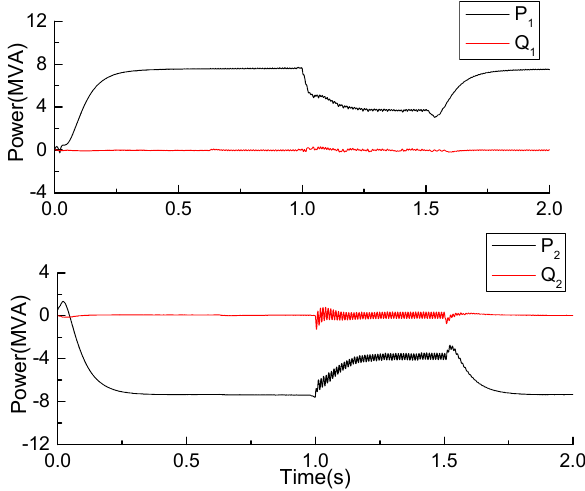
Figure 13. Secondary side system voltage curves: ( a ) system voltages; ( b ) d–q waveforms.